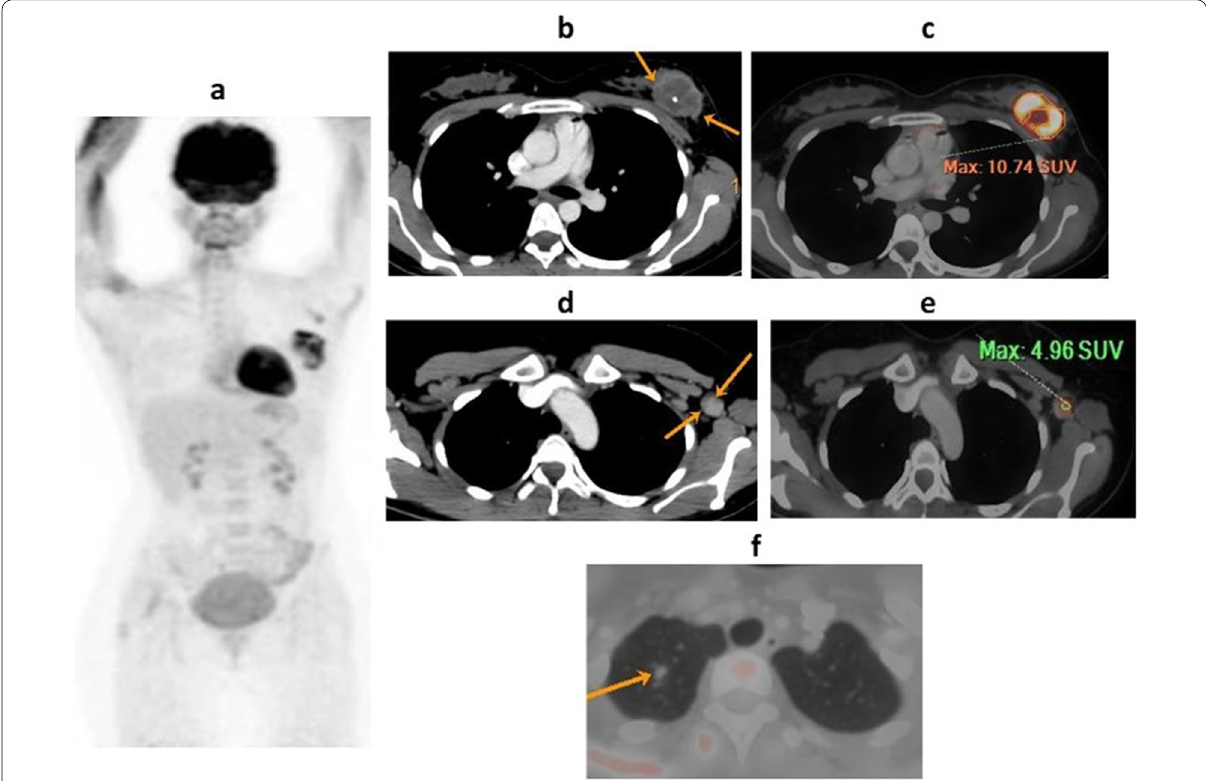
Fig. 3 A 27-year-old female patient arrived with newly diagnosed left breast cancer (IDC grade II). a A whole-body PET MIP picture indicated active lesions in the left breast and axilla. b , c Axial CECT and fused PET/CT scans indicated an active heterogeneously enhancing soft tissue mass lesion in the upper outer quadrant of the left breast, with central inactive patches of necrosis and a minor calcific focus, measuring approximately 30 41 59 mm and attaining a maximum SUVmax of 10.74. d , e Axial CECT and fused PET/CT images revealed few left axillary and subpectoral × × lymph nodes, measuring up to 15 17 mm and achieving up to 4.96 SUVmax. f Axial fused PET/CT image revealed small non-FDG avid pulmonary × nodule at the right lung apex, measuring 6